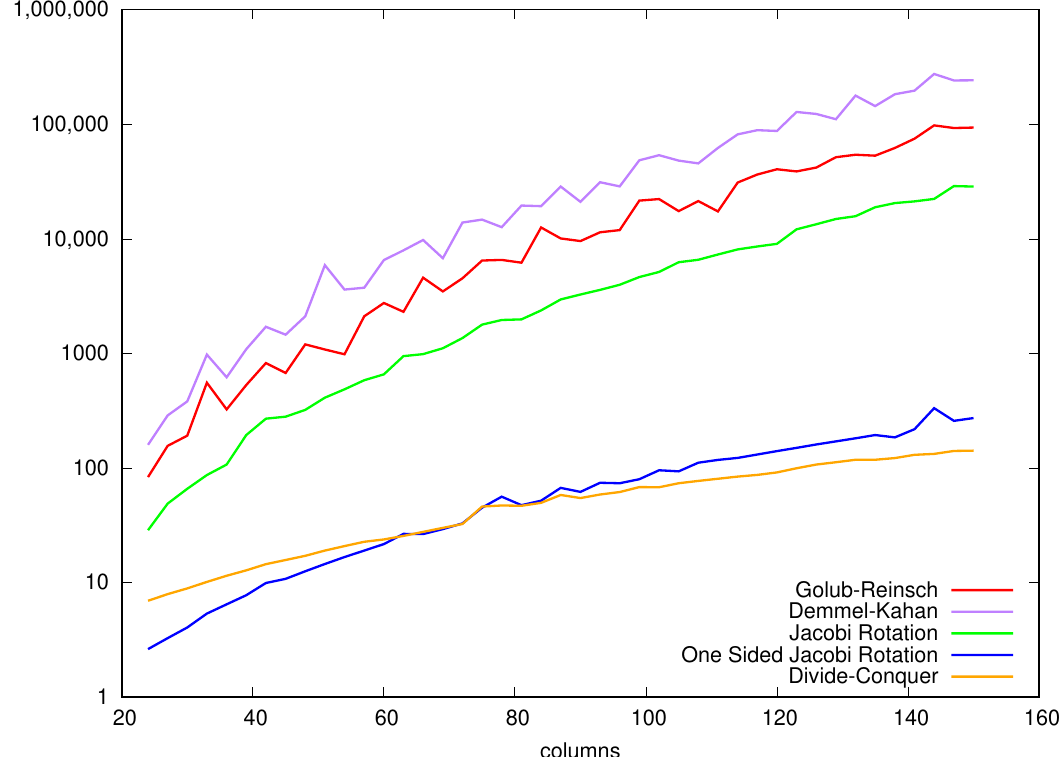
Figure 1. Timings of singular value decomposition (SVD) algorithms implemented in MATLAB for matrices A ∈ R m × n with m / n = 4 3